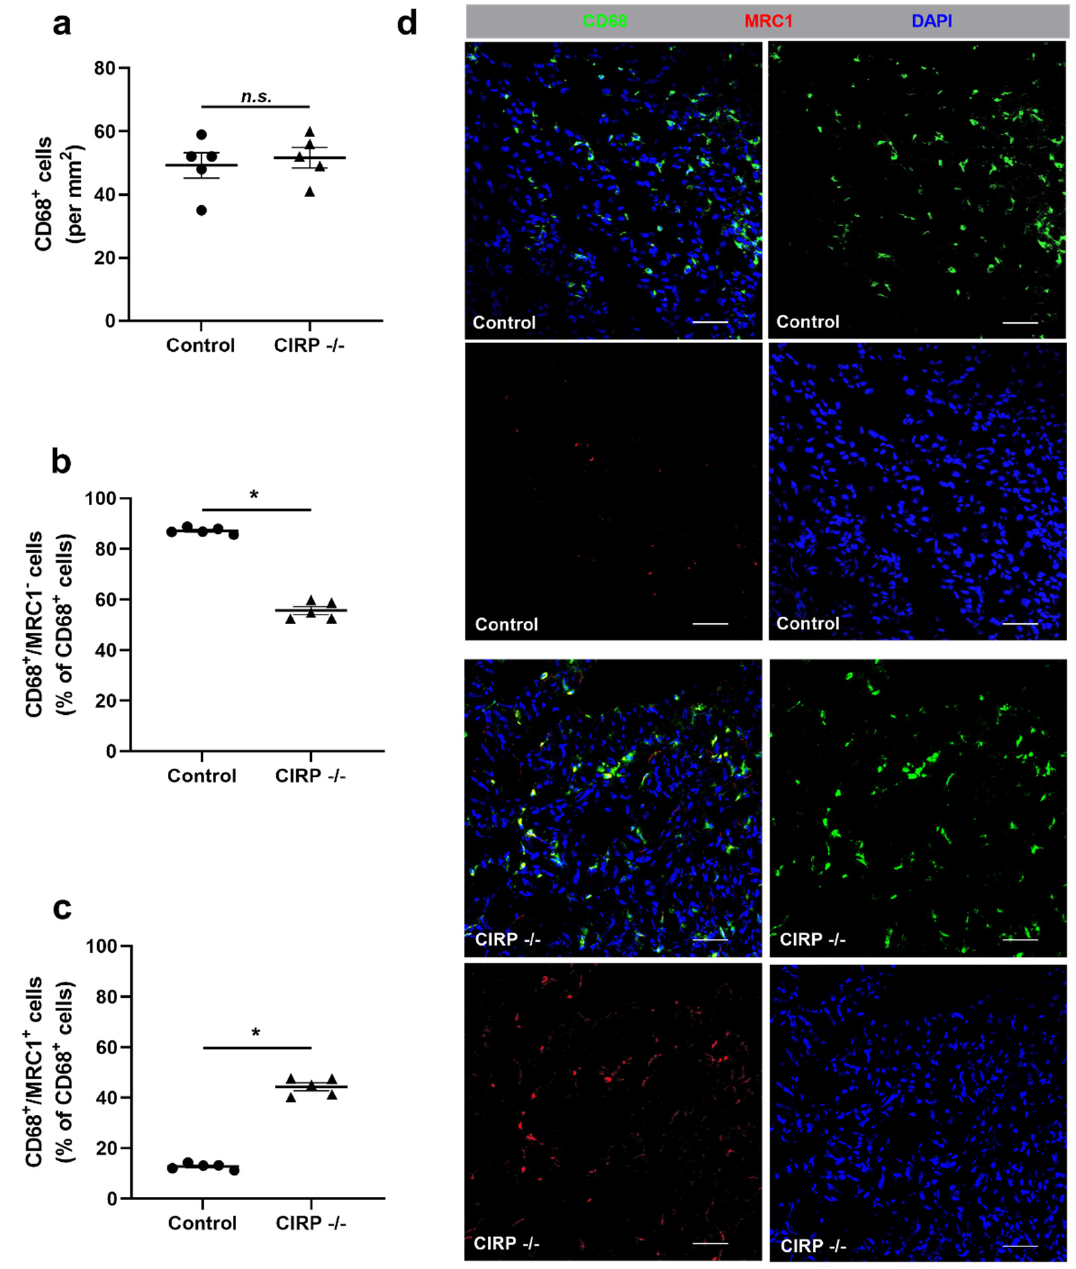
Figure 4. Cold-inducible RNA-binding protein (CIRP) knockout affects macrophage polarization. ( a ) The scatter plots display the relative amount of CD68 + cells (macrophages) (per mm 2 ), ( b ) CD68 + /MRC1 - (mannose receptor c-type 1) (M1-like polarized macrophages), and ( c ) CD68 + /MRC1 + cells (M2-like polarized macrophages) in relation to all CD68 + cells (in%) in ischemic gastrocnemius muscles of CIRP wildtype control and CIRP -/- mice 7 days after femoral artery ligation (FAL). Data are means ± S.E.M., n = 5 per group. n.s. p > 0.05 (( a ) CIRP -/- vs. control), * p < 0.05 (( b , c ) CIRP -/- vs. control) by unpaired, two-sided student’s t-test. ( d ) Representative immunofluorescence staining of ischemic gastrocnemius muscle slices of wildtype control (above) and CIRP -/- mice (below) 7 days after FAL. Images show single and merged channels of CD68 and MRC1 labeled macrophages (anti-CD68, green; anti-MRC1, red) and nucleic acid (DAPI, blue). Scale bars 50 µm.